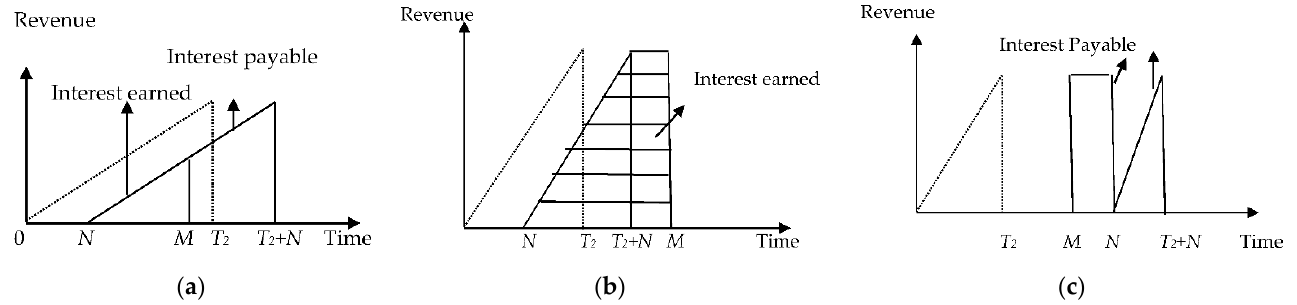
Figure 3. ( a ) Revenue level versus time. ( b ) Revenue level versus time for the accumulated inventory. ( c ) Revenue level versus time.